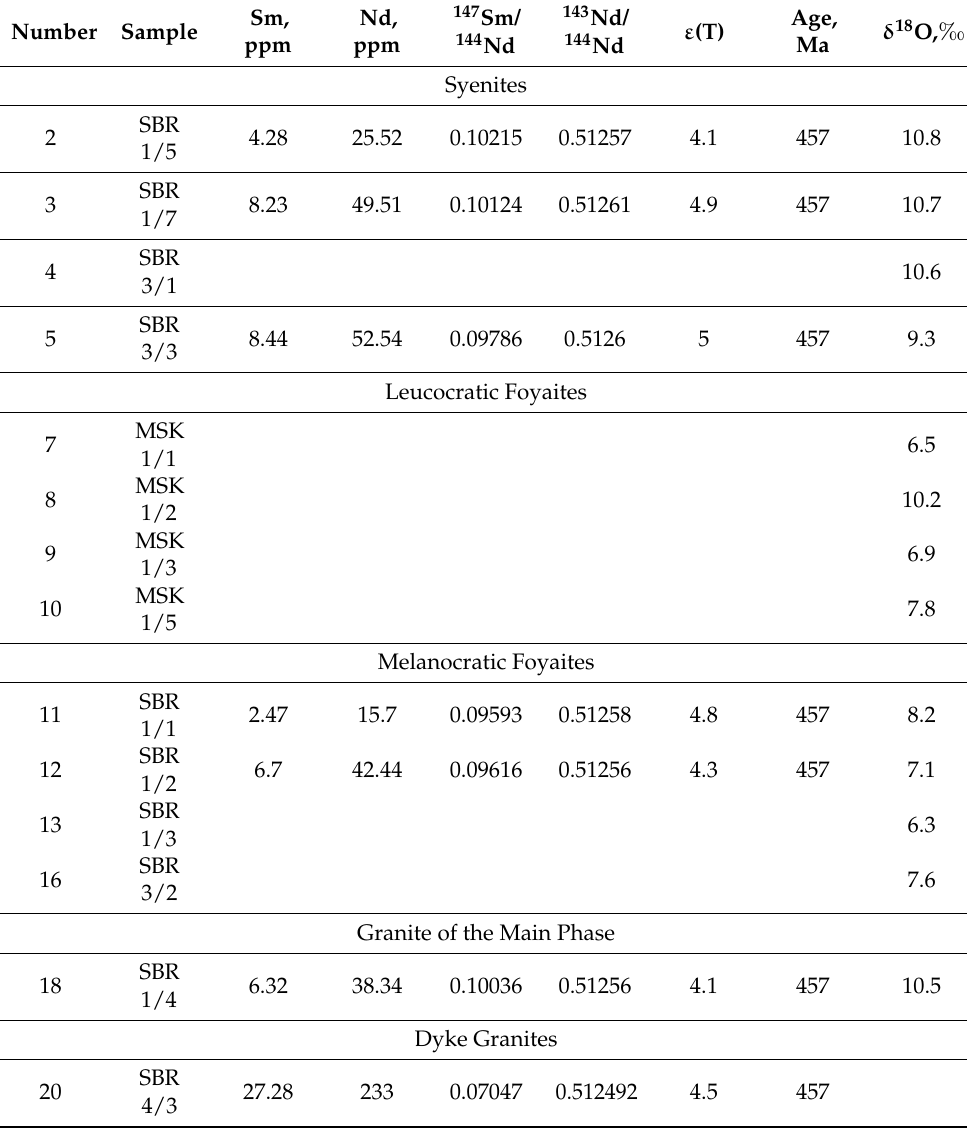
Table 3. δ 18 O, ‰ in alkali feldspars and Sm-Nd isotope compositions in the Saibar